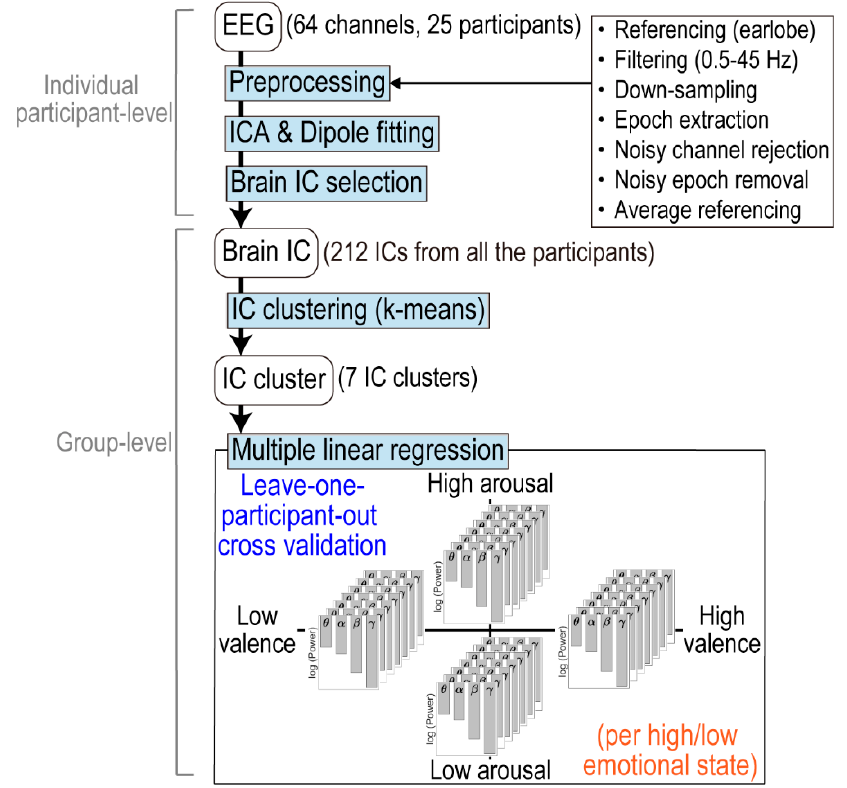
Figure 2. Flow of data processing and analysis. In the regression analysis, valence and arousal levels were predicted by inter-participant regression from logarithms of theta (4–7 Hz), alpha (8–13 Hz), beta (14–30 Hz), and gamma (31–45 Hz) band power of independent components (ICs).